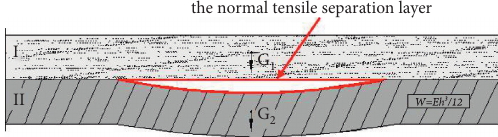
Figure 3: The normal tensile separation layer.